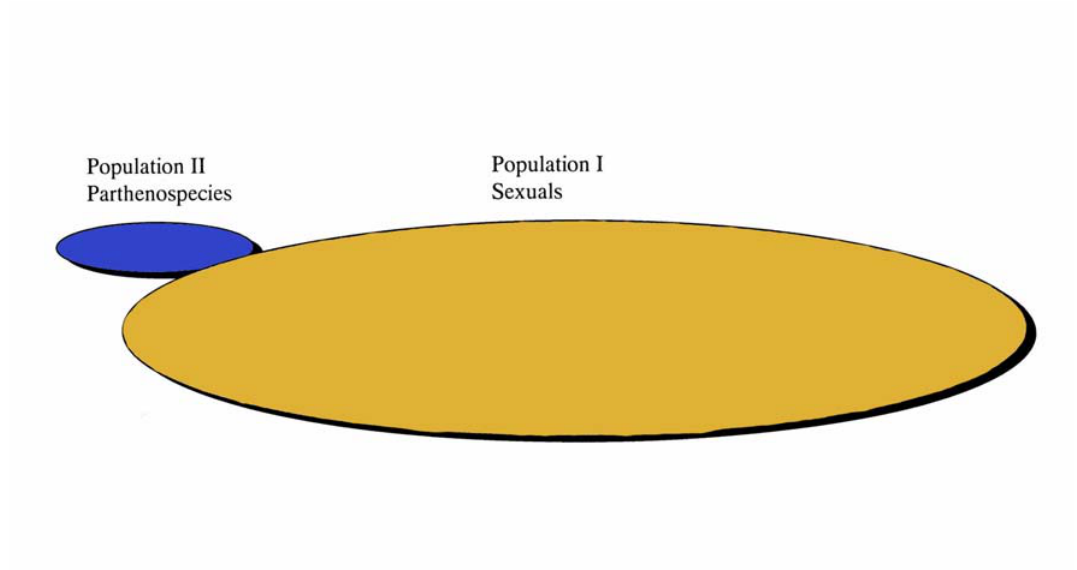
Figure 14. Schematic representation of the distribution of sexual and parthenogenetic populations (geographic